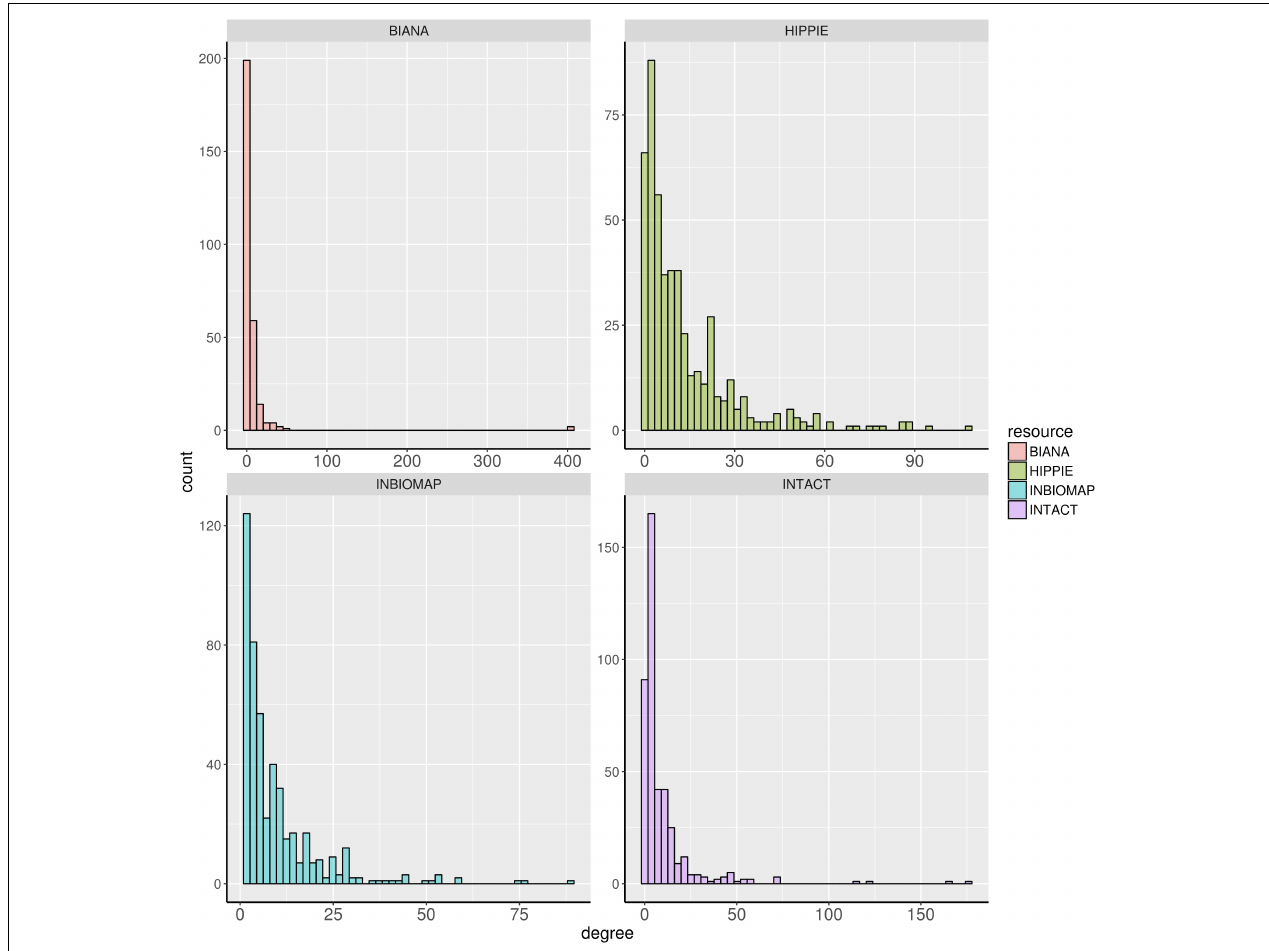
FIGURE 1 | Degree distribution of the dark genes in human interactome databases Biana, HIPPIE, Inbiomap, and IntAct.